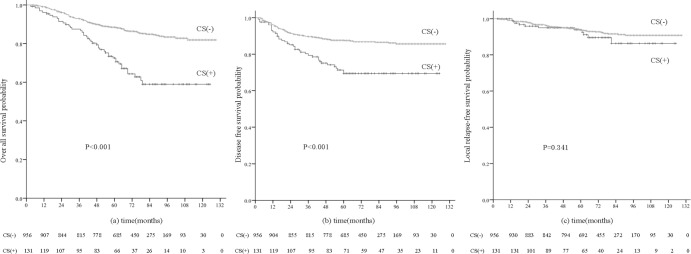
(a) Overall, (b) distant metastasis-free and (c) local relapse-free survival curves for all 1087 NPC patients with and without cavernoussinus invasion (CSI).